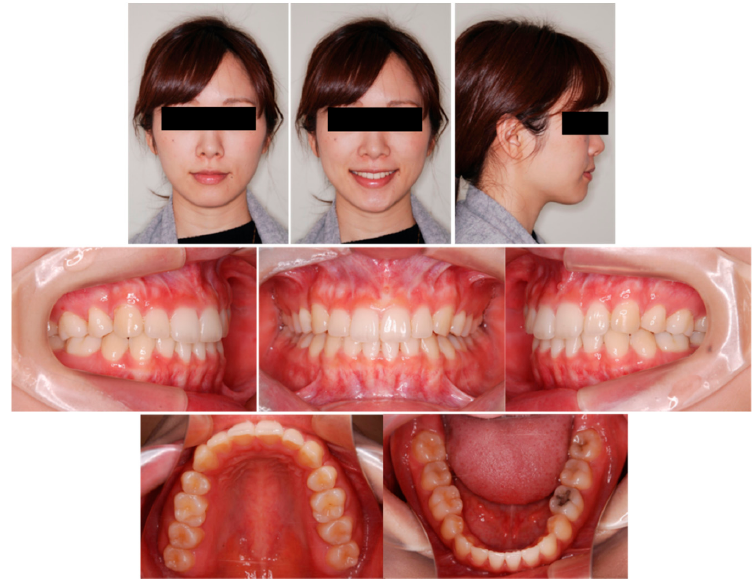
Figure 14. Post-treatment facial and intraoral photographs (after 16 months of start of active treatment; 31 years 2 months old).